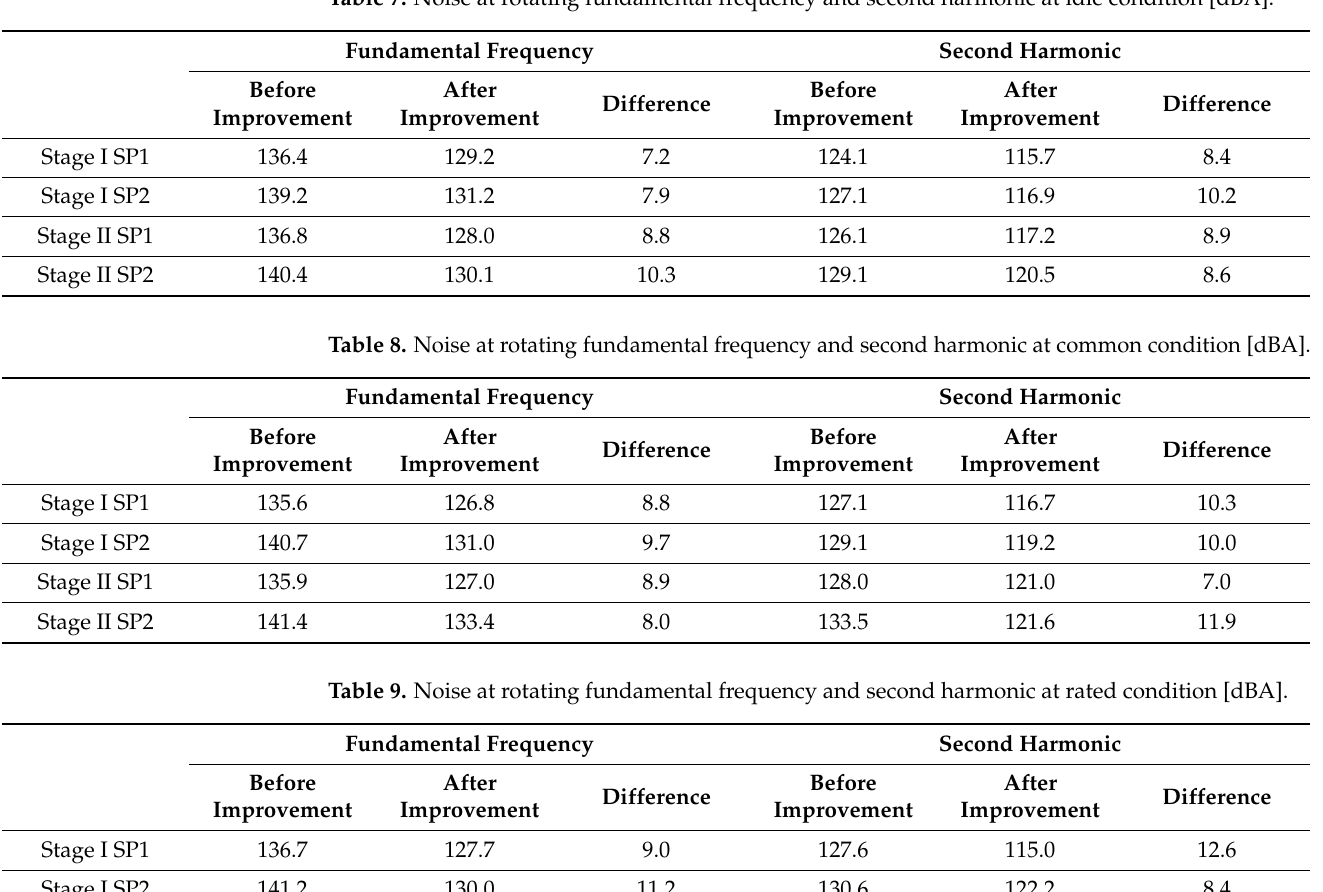
Table 7. Noise at rotating fundamental frequency and second harmonic at idle condition [dBA].